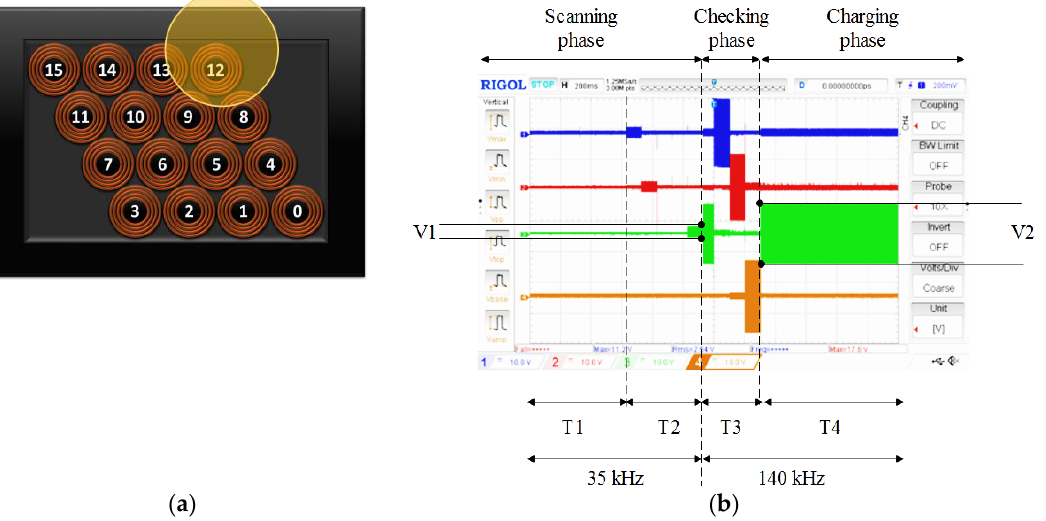
16 of 23 Figure 17. Coils voltages waveform during the scanning phase; blue (CH_1) presents the voltage of coil 4, red (CH_2) presents the voltage of coil 5, green (CH_3) presents the voltage of coil 6 and orange (CH_4) presents the voltage of coil 7. The voltage waveform in Figure 18b, Figure 19, and Figure 20b presents the four-transmitting coils; C8, C9, C12, and C13. The oscilloscope channels contain C8 with the blue curve (CH_1), C9 with